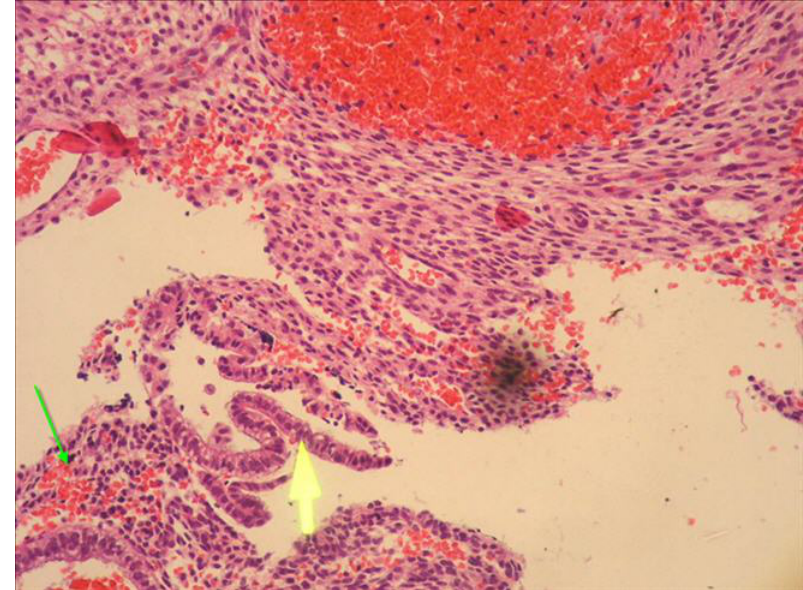
FIGURE 6 . Microphotograph 40 × 10, showing endometrial glands, hemosiderin-laden macrophage, and areas of hemorrhage. Features of endometriosis.